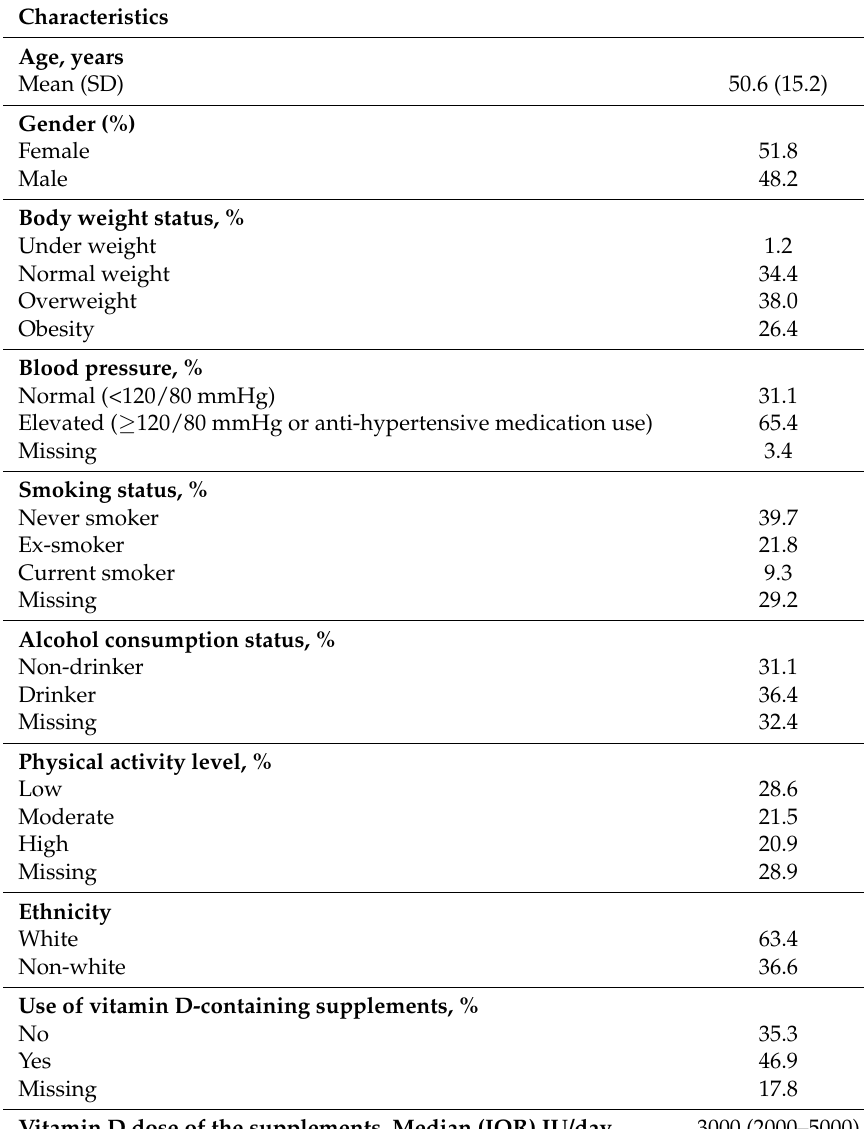
Table 2. Baseline characteristics of 6812 study